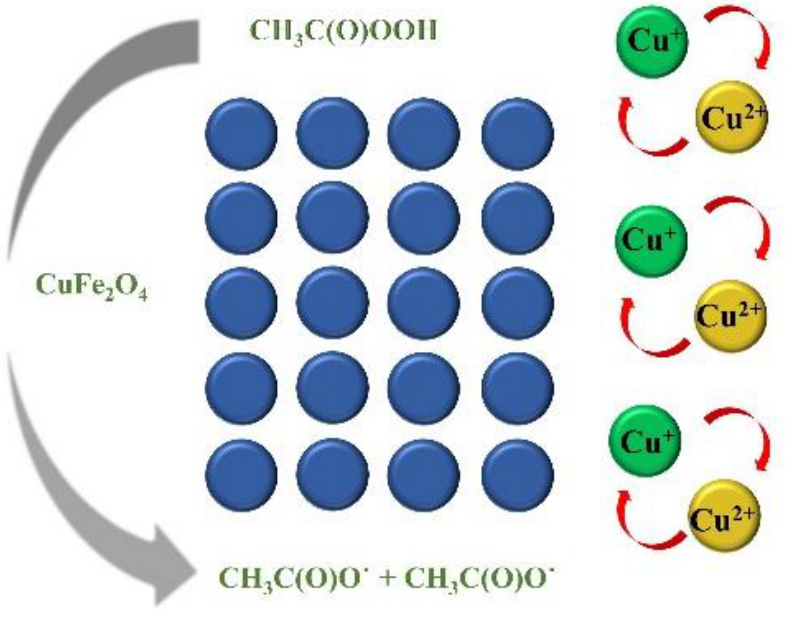
Figure 6. The proposed mechanism of the CuFe 2 O 4 /PAA system.